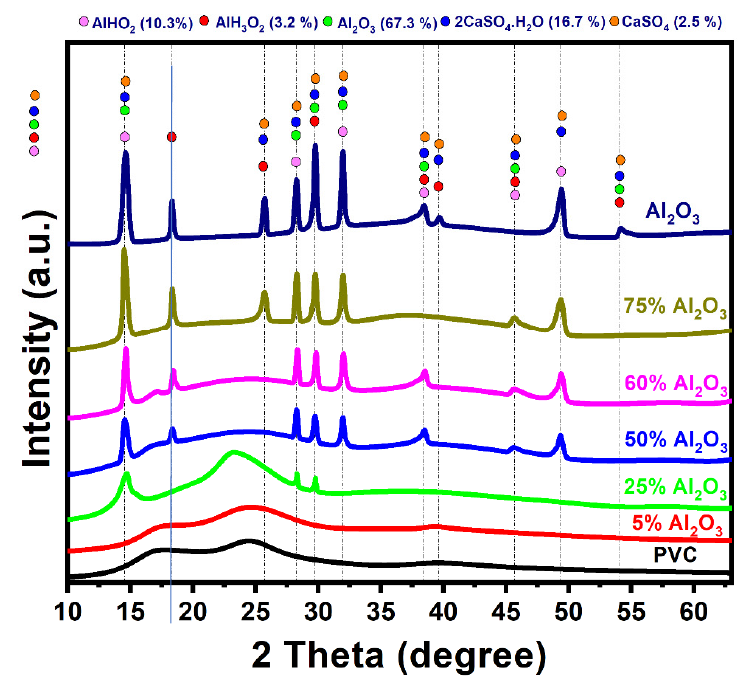
Figure 2. XRD patterns produced by Al 2 O 3 , PVC, and Al 2 O 3 /PVC samples containing different aluminum trioxide amounts.